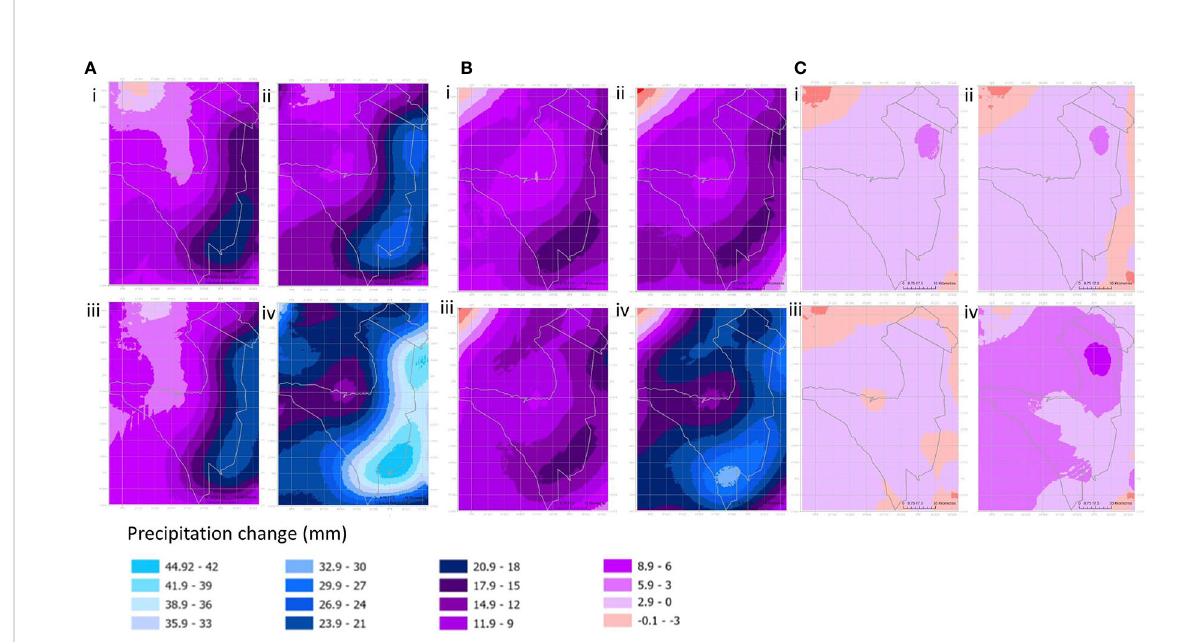
FIGURE 3 Predicted changes in mean precipitation during the short rainy season (A) , long rainy season (B) and dry season (C) for the wider Serengeti ecosystem. For each panel, there is a comparison of mean precipitation change from 1975 to (i) to 2055 under RCP4.5, (ii) to 2085 following RCP4.5, (iii) to 2055 following RCP8.5, and (iv) to 2085 following RCP8.5. All are multiple-model ensemble derived from AFRICLIM (Platts et al., 2015; Miatt,